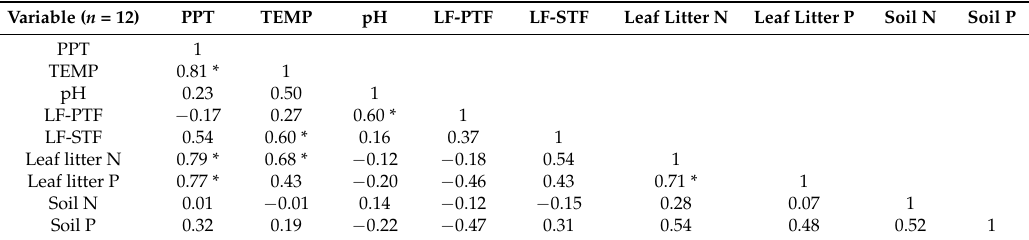
Figure 2. Litterfall in relation to precipitation. Solid circles represent the site primary tropical forest (PTF) and empty circles the site secondary tropical forest (STF). Table 2. Correlations (Pearson’s) between climate (PPT and TEMP) and leaf litter; and soil nutrient pools from the study sites.